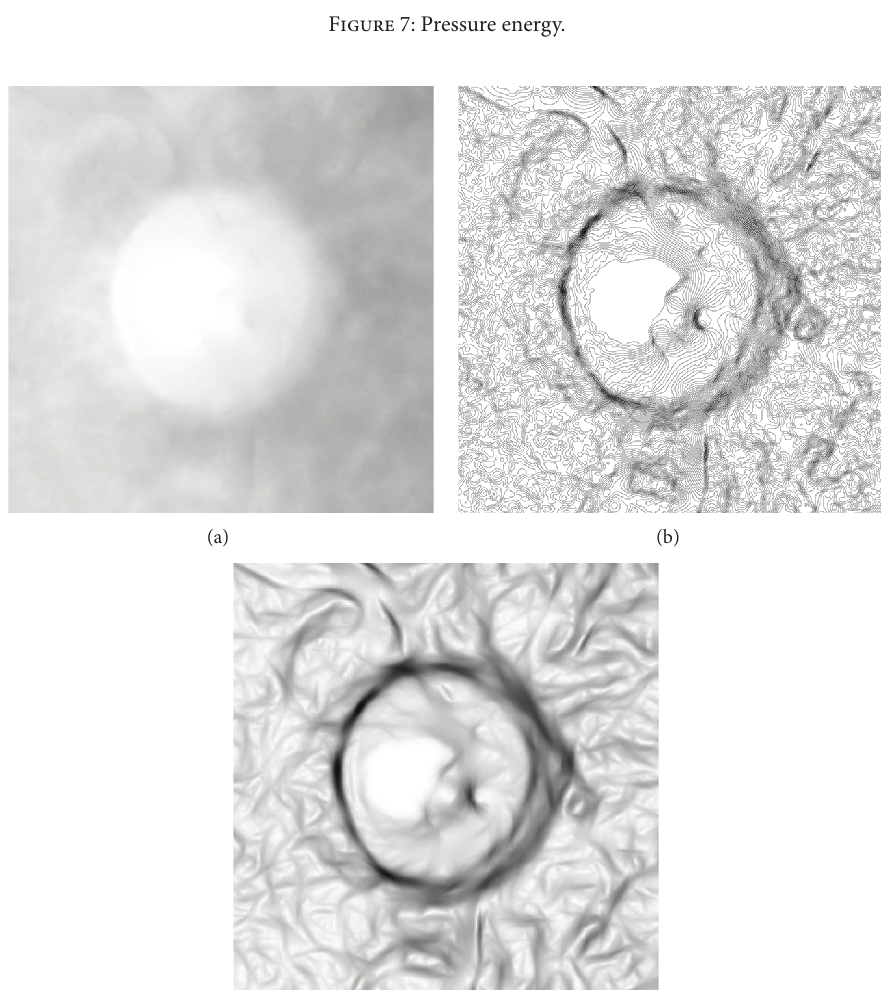
Figure 8: Image gradient and texture. (a) Raw image. (b) Image gradient. (c) 3rd response from